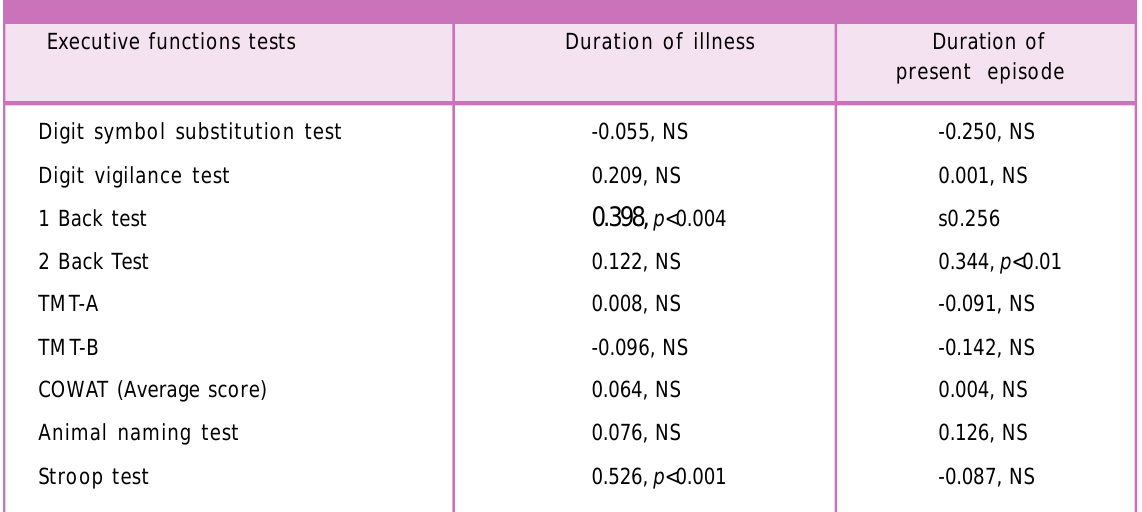
Table 6. Correlation between duration of illness and executive